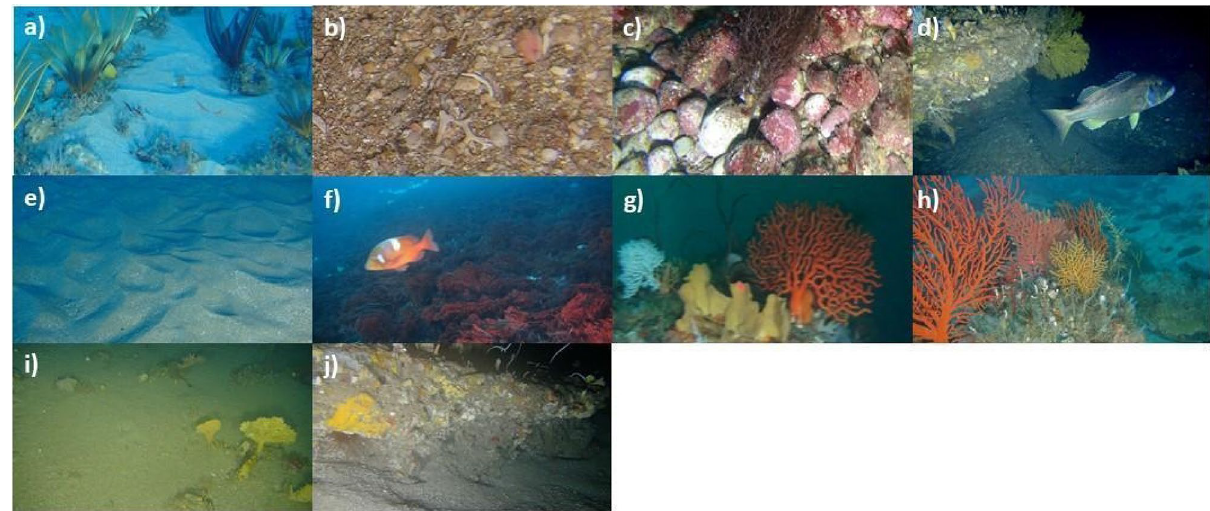
Figure 3. Images of dominant habitat for substrate clusters: (a) sand, (b) rubble, (c) rhodoliths and (d) rock. Biota clusters included: (e) no biota, (f) algae, (g) soft corals & sponges and (h) fan coral; and relief clusters (i) flat and (j) low, were extracted from the ROV transect